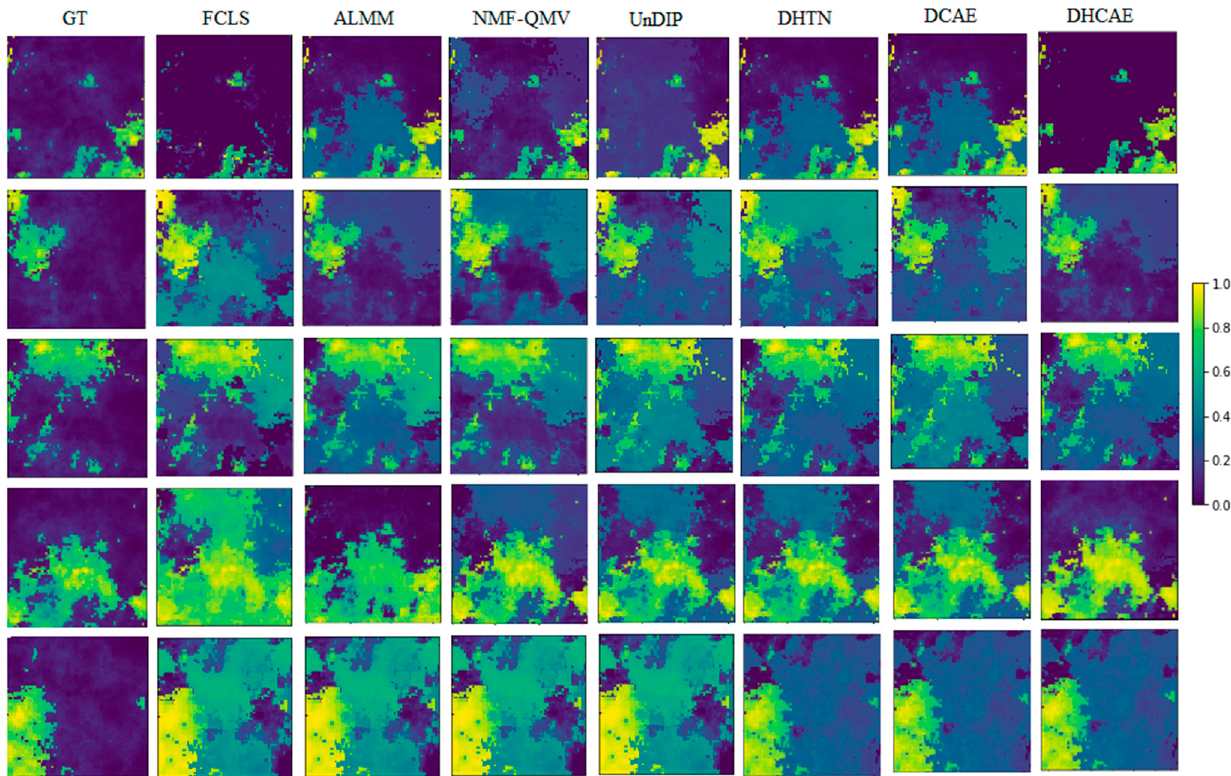
Figure 4. Synthetic data. Ground truth (GT) map in the first column and extracted abundance maps comparison by different spectral unmixing methods.